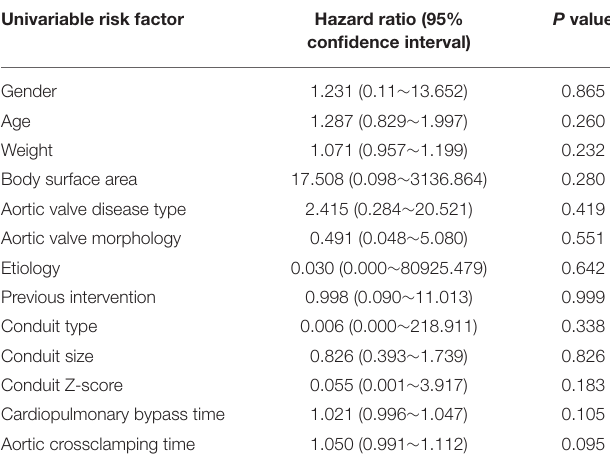
TABLE 3 | Univariable risk factors for conduit dysfunction after Ross